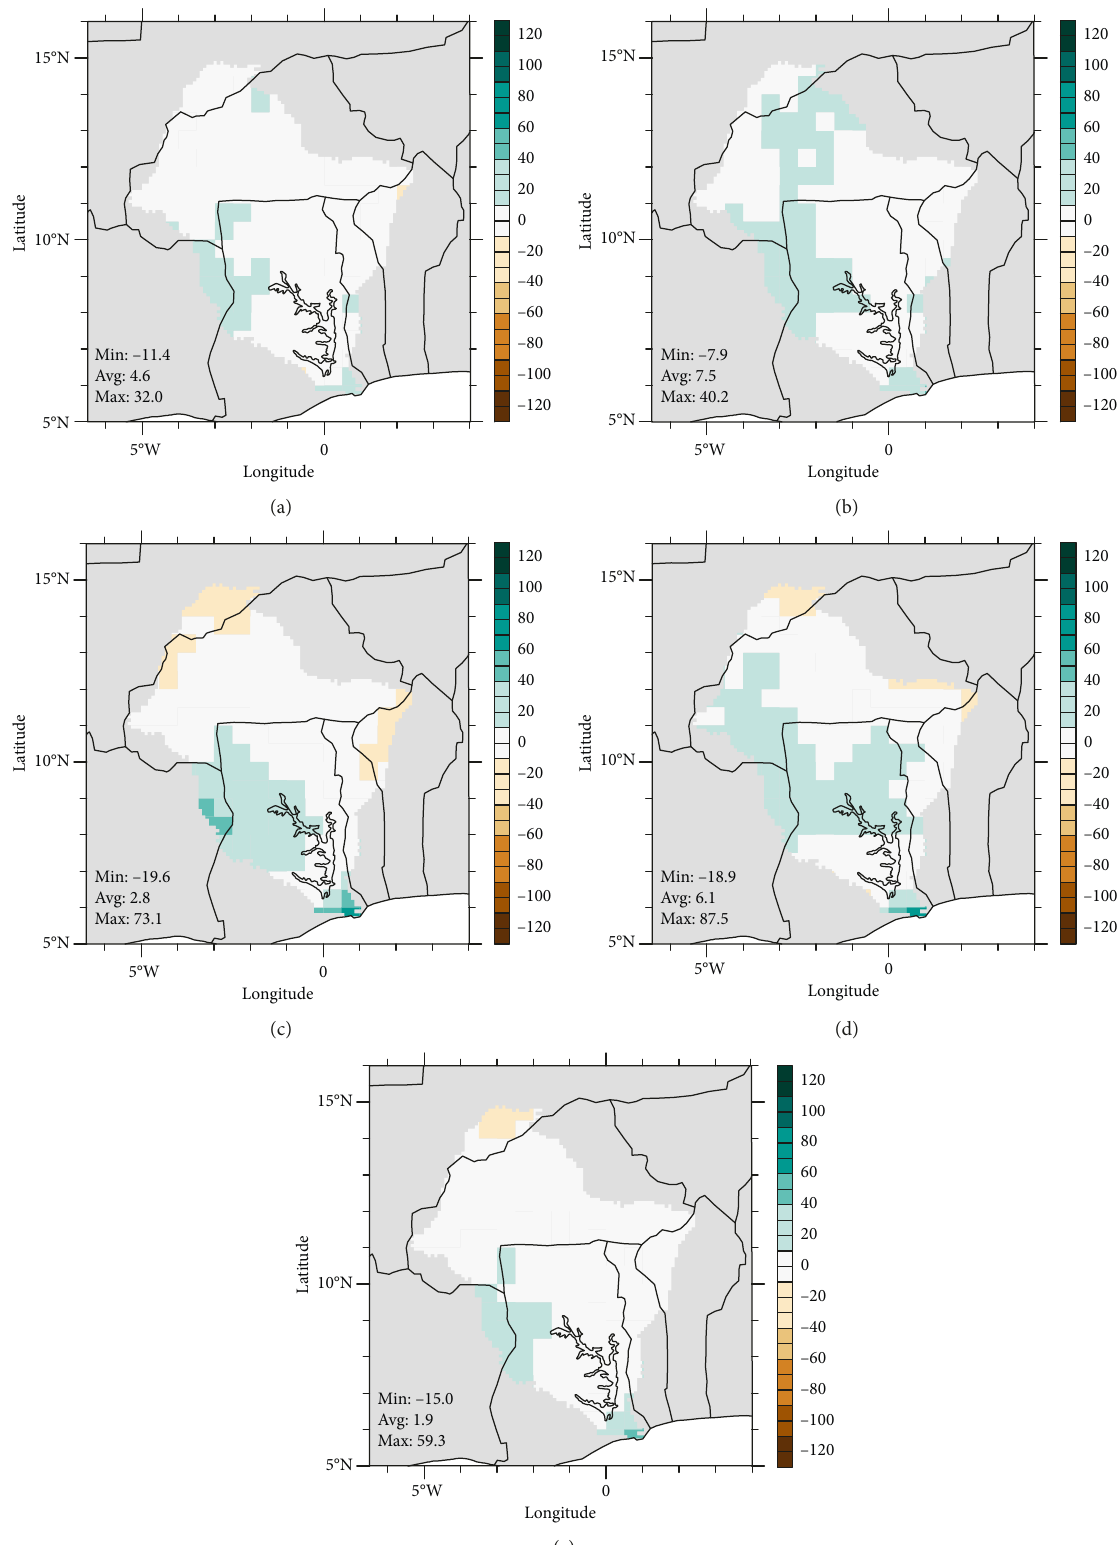
Figure 5: The climatological (1950–2004) mean bias in the annual total precipitation for the models: CESM1-BGC (a), CCSM4 (b), NorESM1-M (c), MPI-ESM-MR (d), and ensemble mean (e), simulating the observed climatological mean relatively well over the Volta